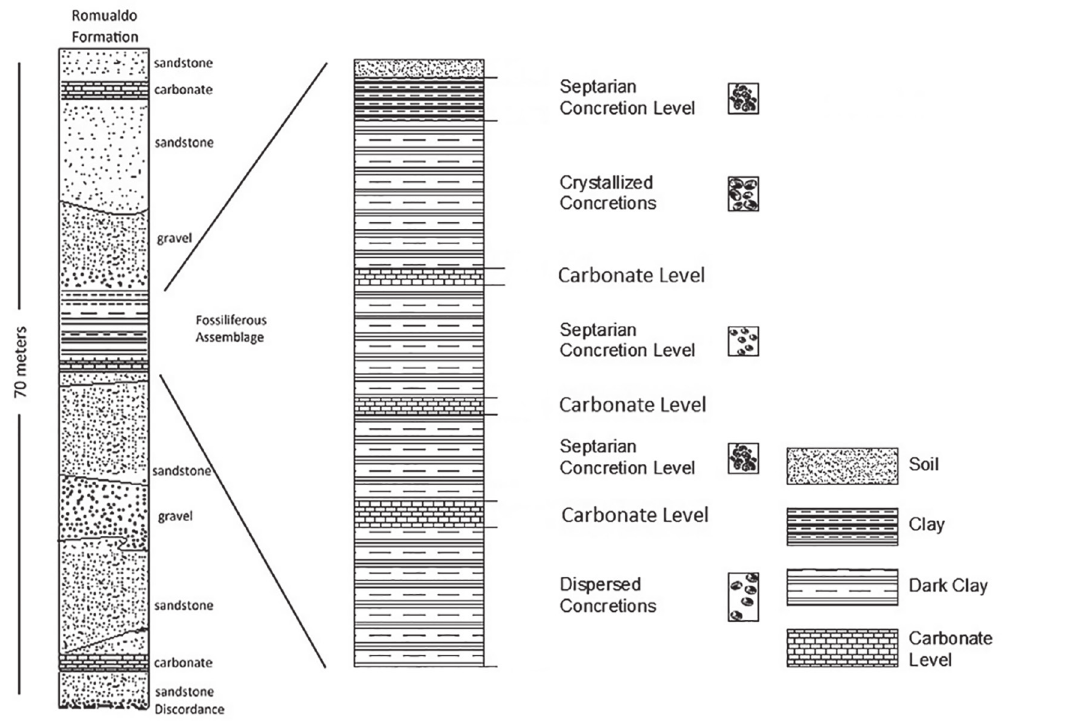
Figure 2 - Stratigraphic general scheme of the Romualdo Formation (Cretaceous – Albian). The details of the fossiliferous assemblage are hypothesized from correlated areas (according to Vila-Nova et al.